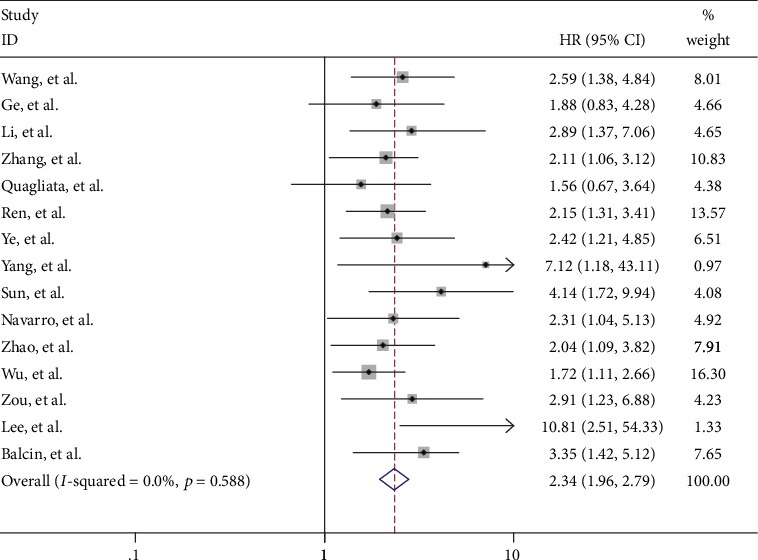
Forest plot of the pooled HRs of elevated HOTTIP expression for OS for the included studies.